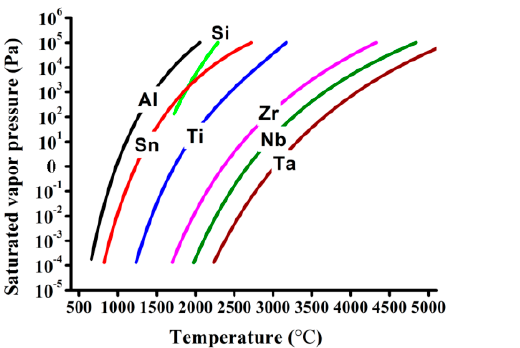
Figure 3. Chemical compositions of the wire feedstock and the as-built alloy along the build direction, Al, Sn, Zr ( a ) and Ta, Nb, Si ( b ).